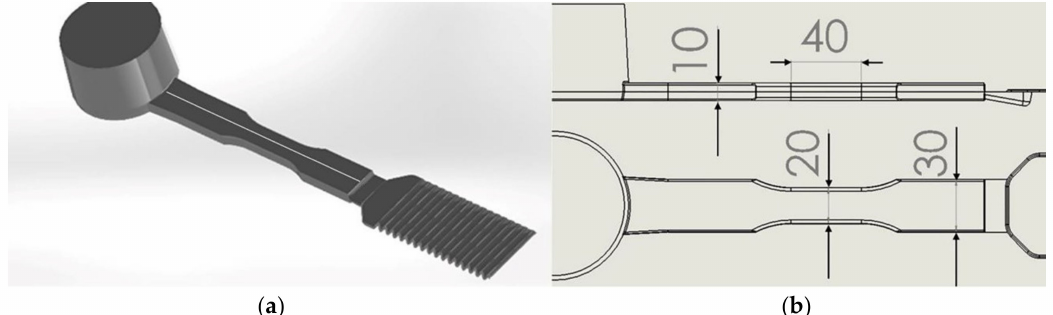
Figure 2. ( a ) Casting shape; ( b ) cast tensile bar. Dimensions in